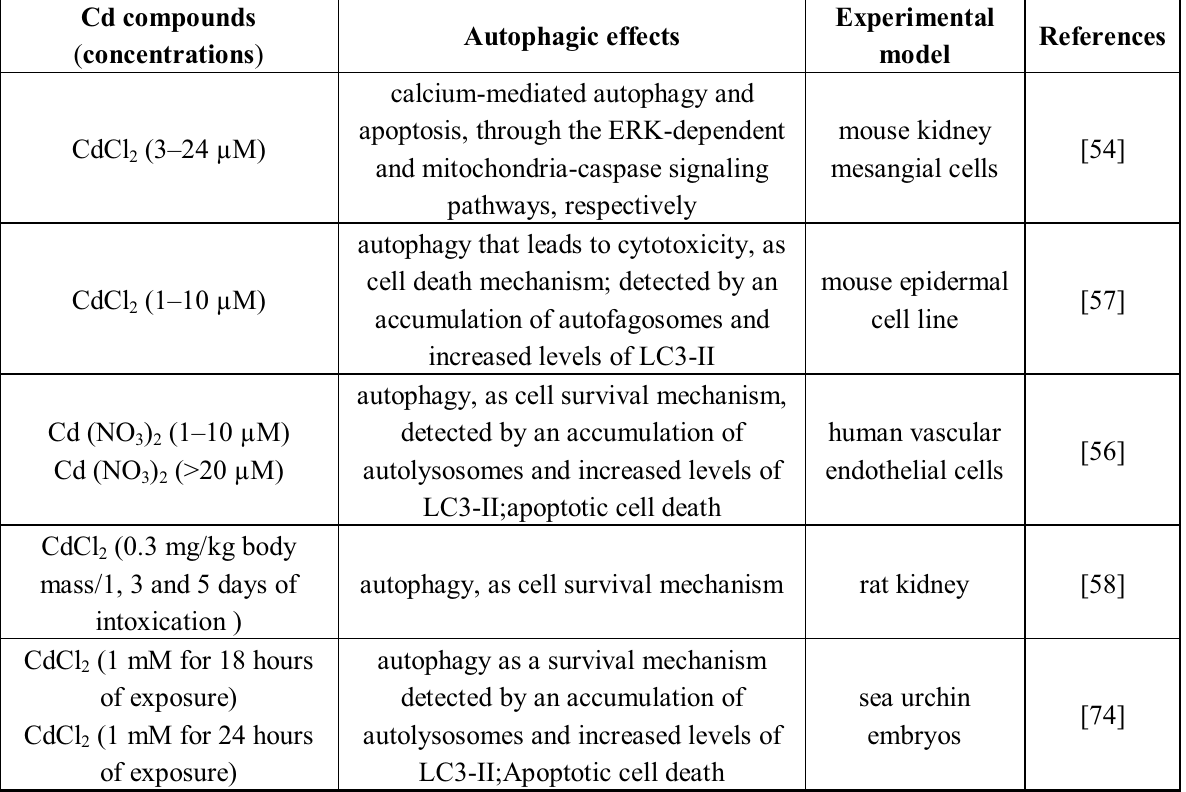
Table 2. Cadmium concentration and induced cellular response with respect to